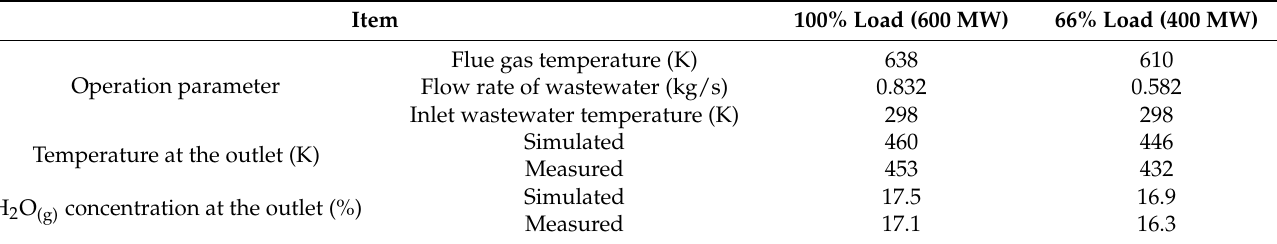
Table 3. Comparison between the simulated and measured